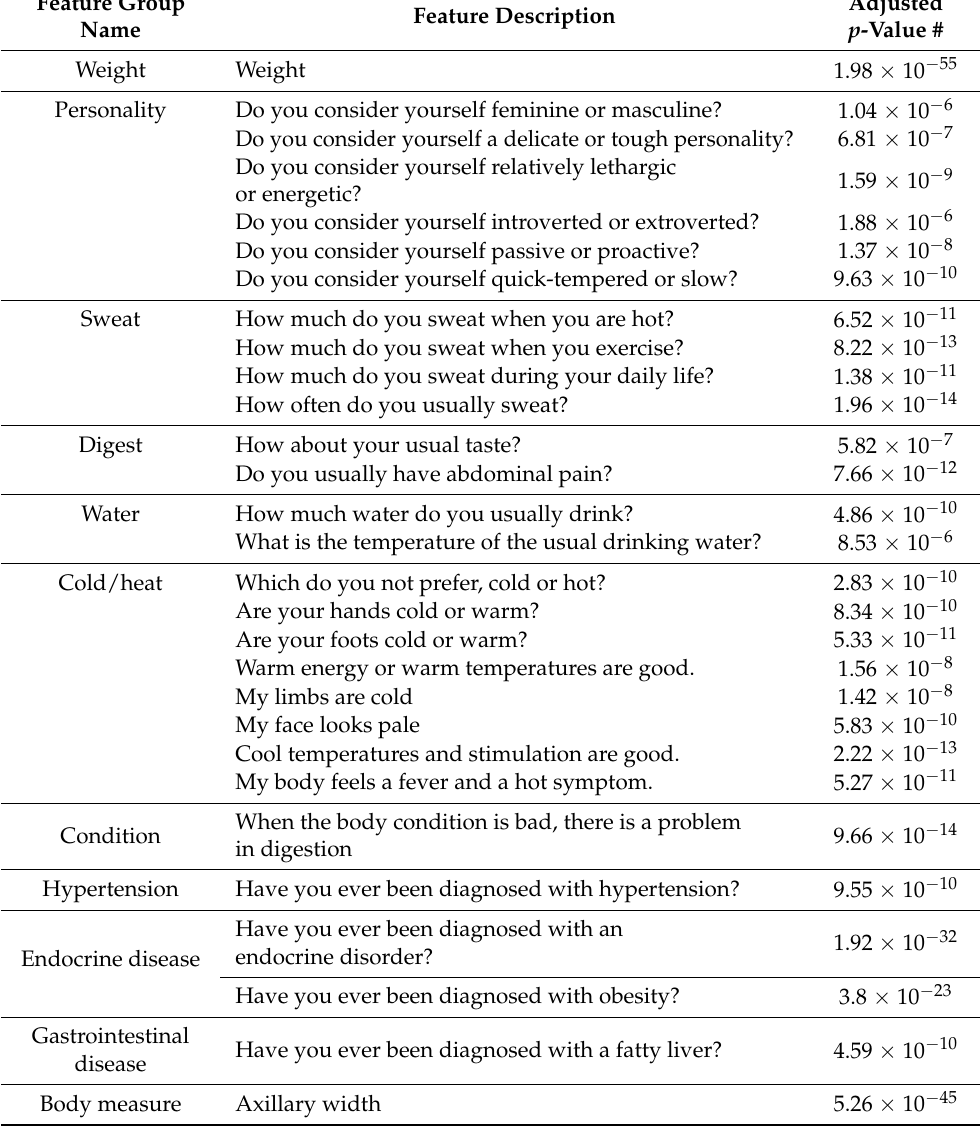
Table 4. Description of features related to Sasang